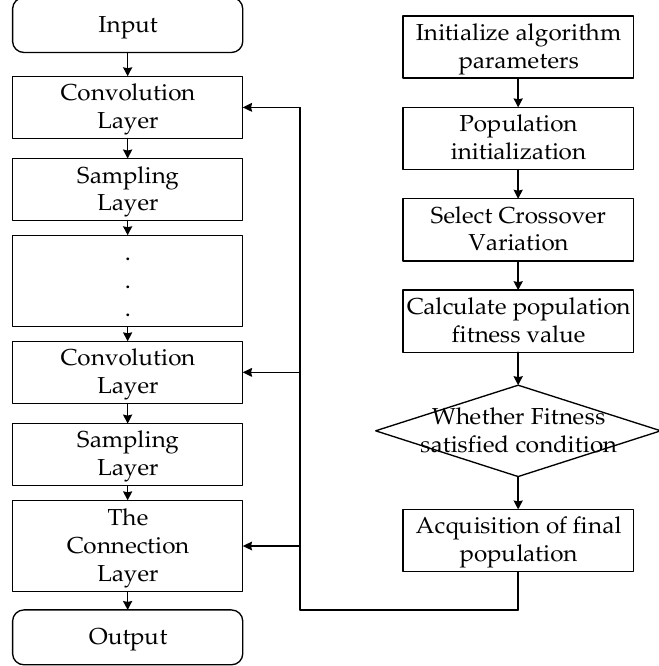
Figure 7. GA-CNN implementation flowchart.